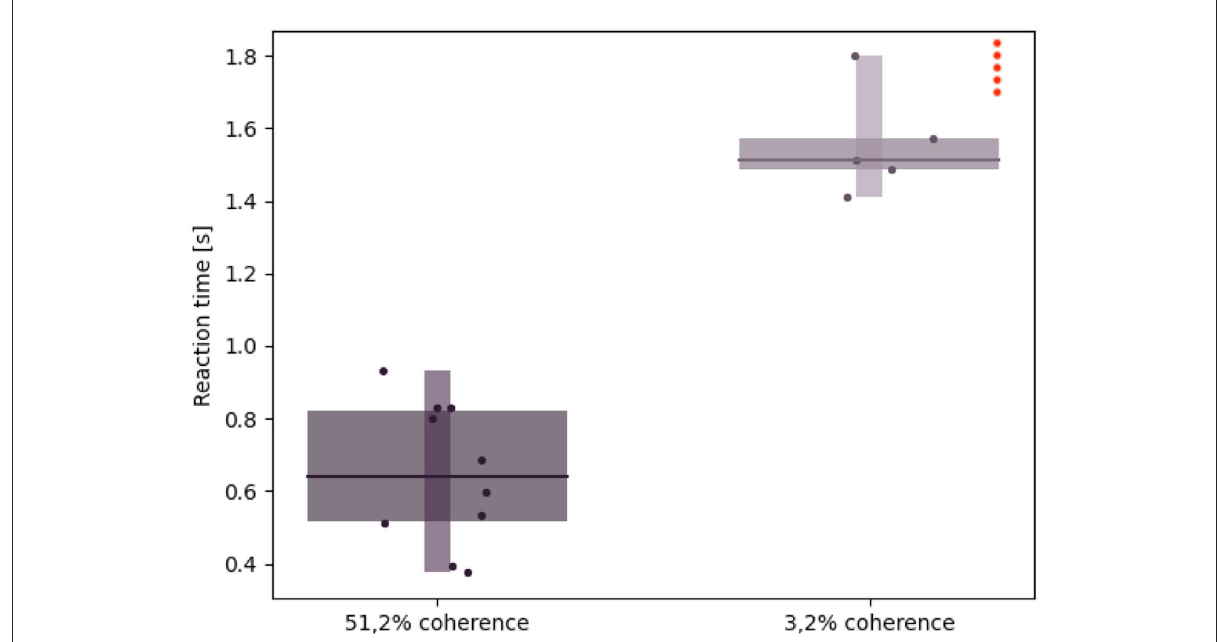
FIGURE11 Robotic subject’s reaction times: Whisker plot showing the reaction time (i.e., the time needed by the iCub to rotate its cameras by an angle greater than 0,08 rad after the stimulus onset) during 10 different trials and with different stimulus coherence values. The red dots on the upper right corner represent failed trials, in which either the reaction time exceeded 2 s or the saccadic movement didn’t surpass the threshold (hence, no decision was